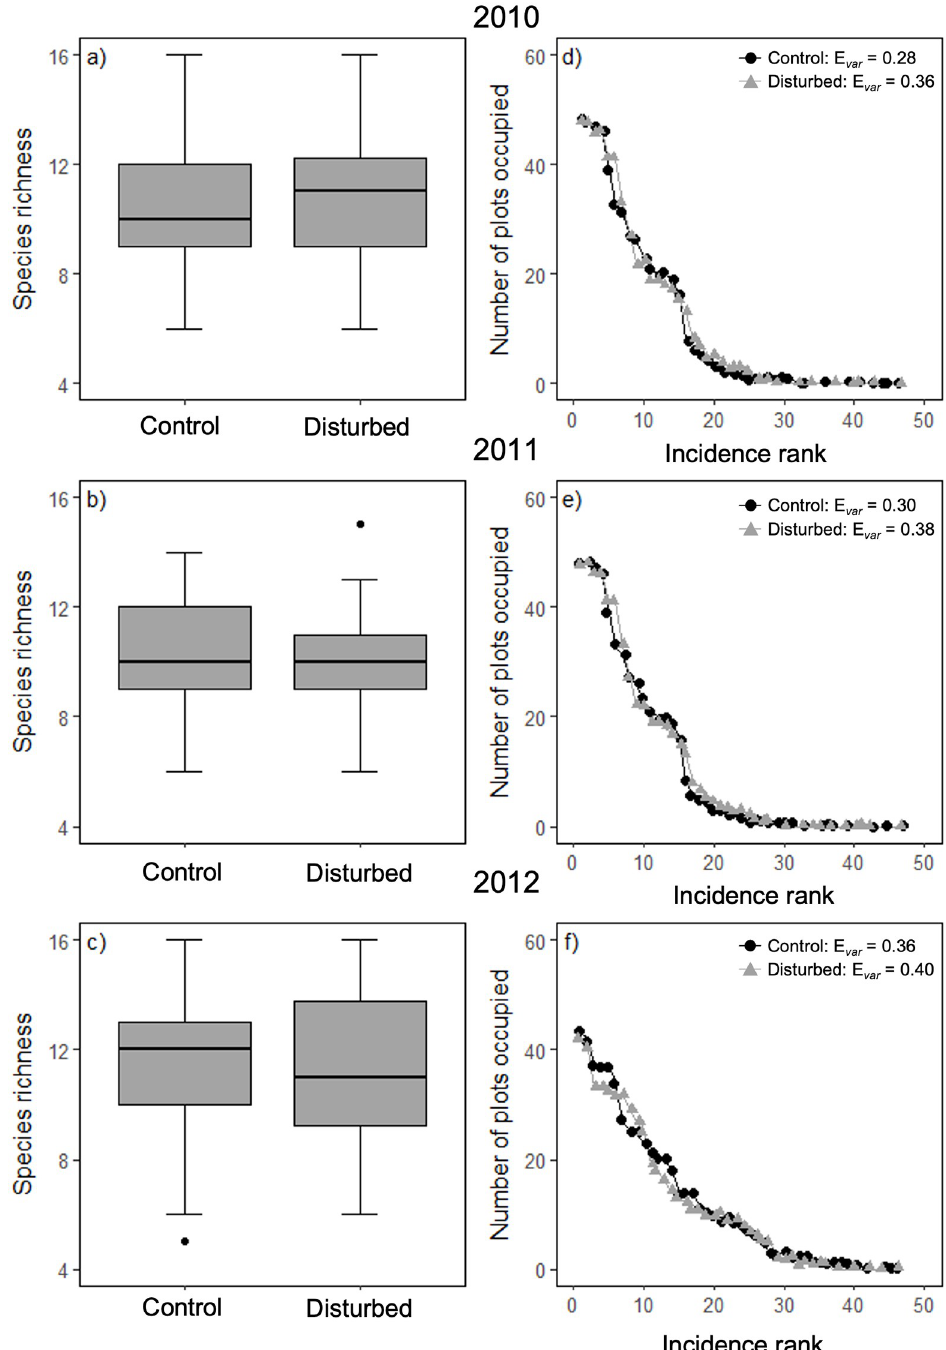
Fig 2. Species richness boxplots and rank incidence graph. Boxplots illustrating species richness in control and disturbed plots (48 plots per treatment) for 2010 (A), 2011 (B), and 2012 (C). Boxes represent the 25 th to 75 th percentiles of the data, and whiskers represent the 10 th and 90 th percentiles. Points above and below the box represent the 5 th and 95 th percentile outliers. Graphs showing rank incidence for the control and disturbed plots in 2010 (D), 2011 (E), and 2012 (F). Black circles represent incidence rankings for the control treatment, and grey circles represent incidence rankings for the disturbed treatment. Species richness did not differ between treatments or across years.